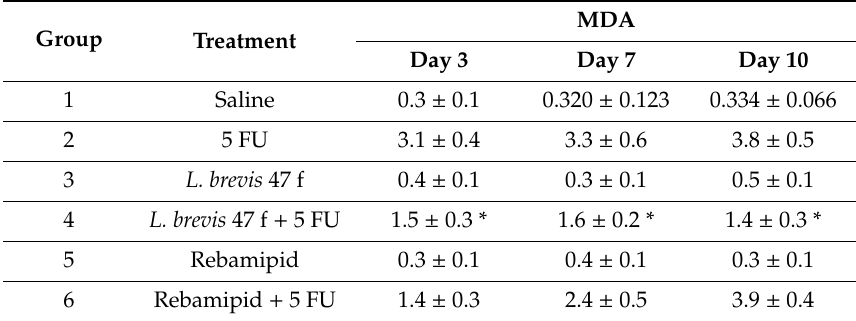
Table 4. Time course of MDA levels in the female intestine.